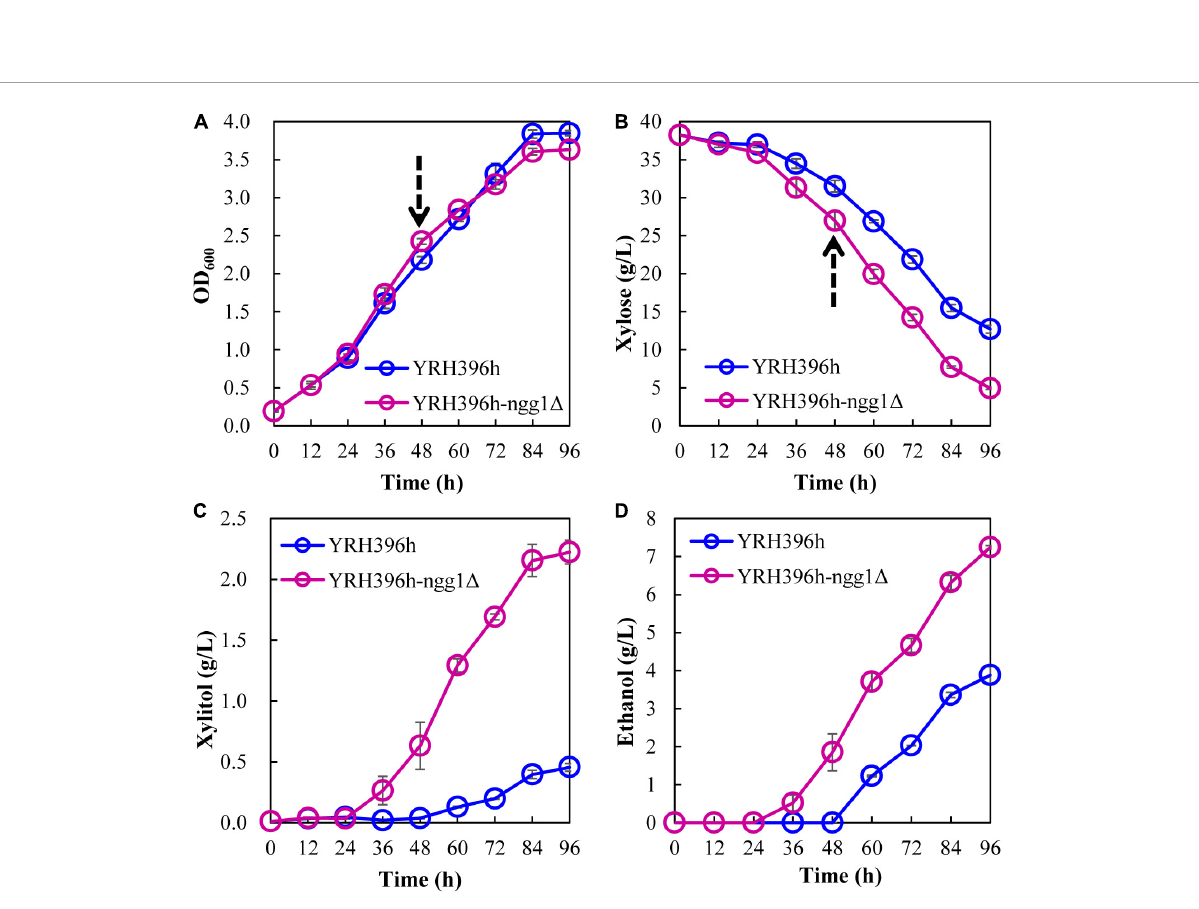
FIGURE3 Effect of NGG1 deletion on xylose fermentation of S. cerevisiae YRH396h. Batch fermentation was performed in 100 mL medium containing 4 g/L yeast extract, 3 g/L peptone, and 40 g/L xylose in 250 mL Erlenmeyer flasks with the initial OD 600 of ∼ 0.2 shaking at 150 rpm and 30 ◦ C under micro-aerobic condition. (A) Growth ability, (B) Xylose consumption, (C,D) Xylitol and ethanol generation. The arrows at 48 h indicate the time points of sample collection for comparative transcriptomic